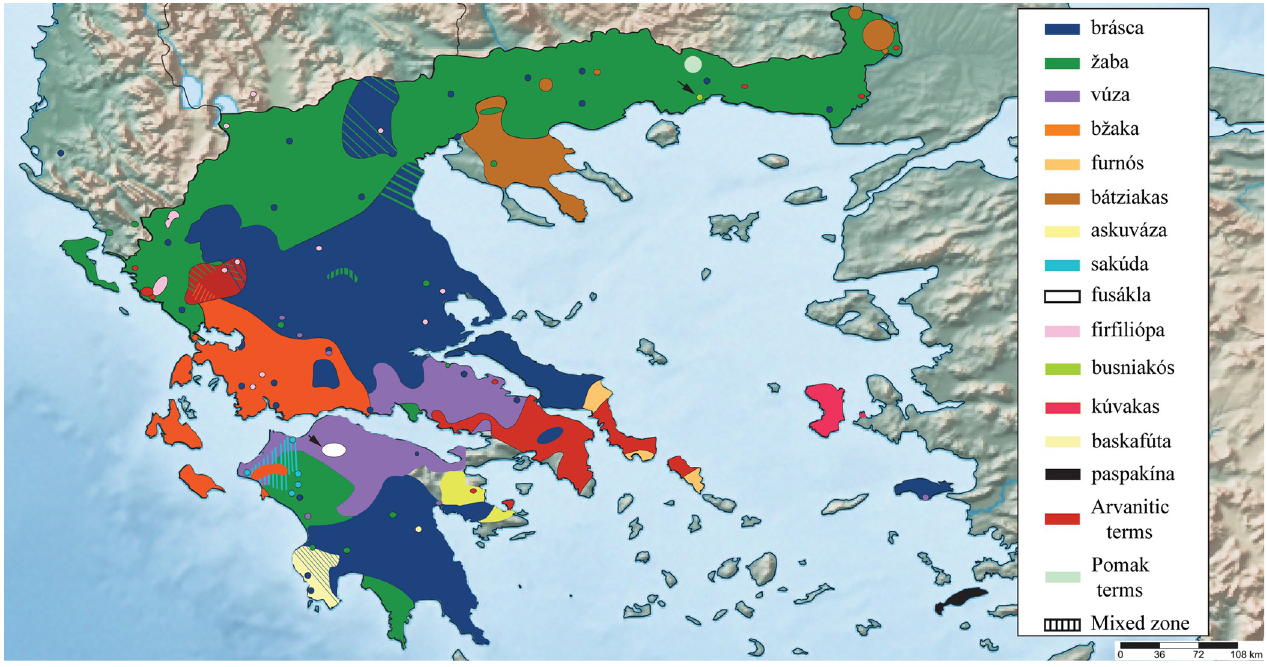
Fig 2. The geographic distribution of the main zoonyms of Bufo bufo in Greece, based on the data of Fig 1. Zoonyms of limited geographical distribution are not depicted. Dashed colours indicate the existence of mixed zones where multiple zoonyms co-occur. The unicoloured areas are schematic and do not exclude the existence of linguistic “islands” of different zoonyms within their boundaries, which may have not been identified in the present survey. Also, in mixed zones where multiple zoonyms co-occur, the degree of use of each term by the local population (i.e whether one zoonym is dominant, while another is falling out of use) is not depicted. It should be stressed that the maps of Central and Eastern Macedonia, as well as those of Thrace, do not depict the drastic demographic and linguistic changes that took place in these regions during the 20 th century. Uncoloured areas denote parts of Greece that were not sampled by the present study, urban centres, and regions where the common toad does not